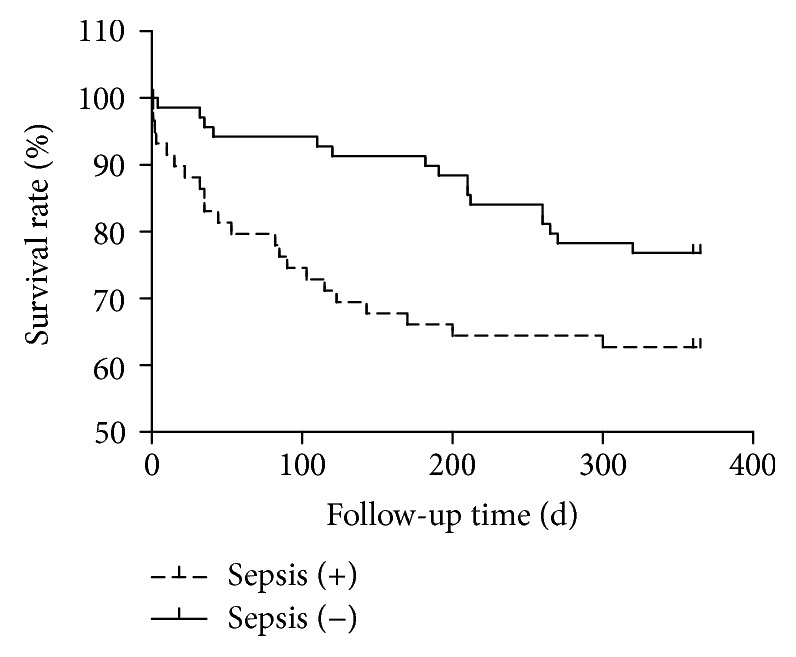
Survival rate and sepsis.